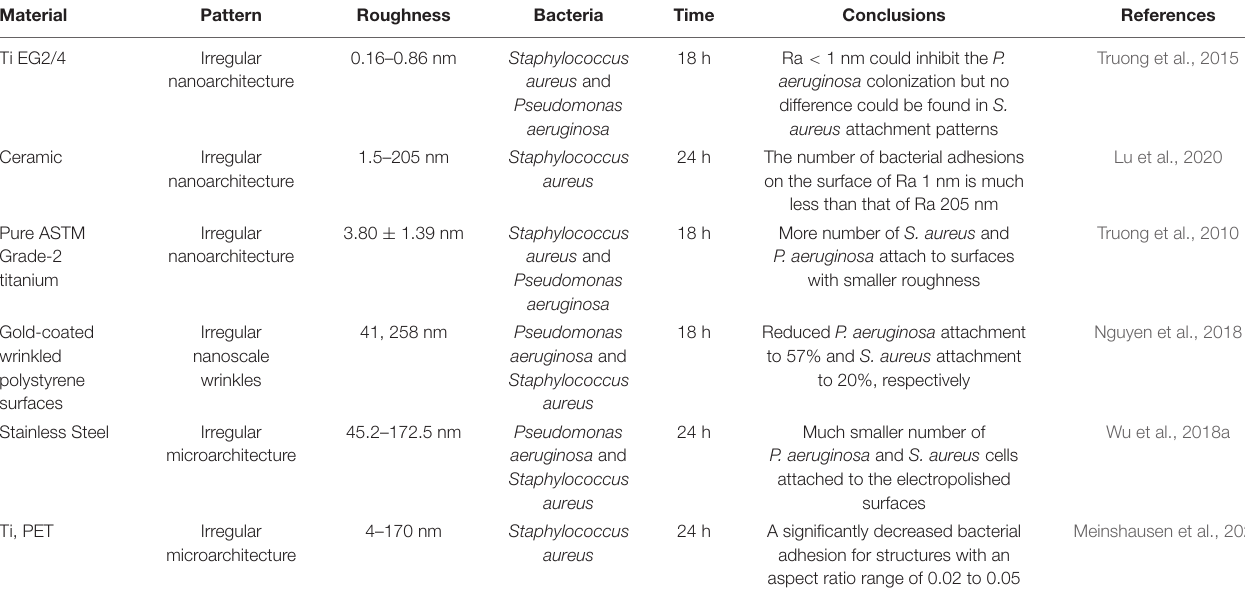
TABLE 2 | Summary of the effects of substrates’ roughness on bacterial adhesion